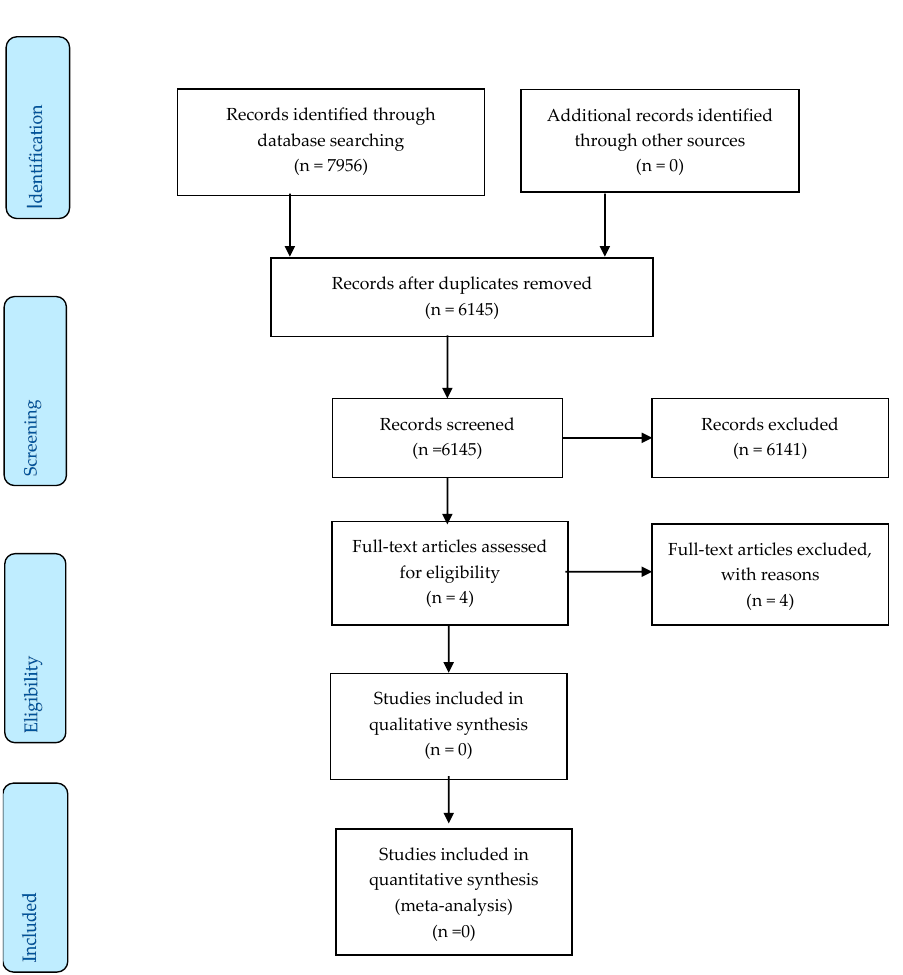
Figure 1 PRISMA Flow Diagram